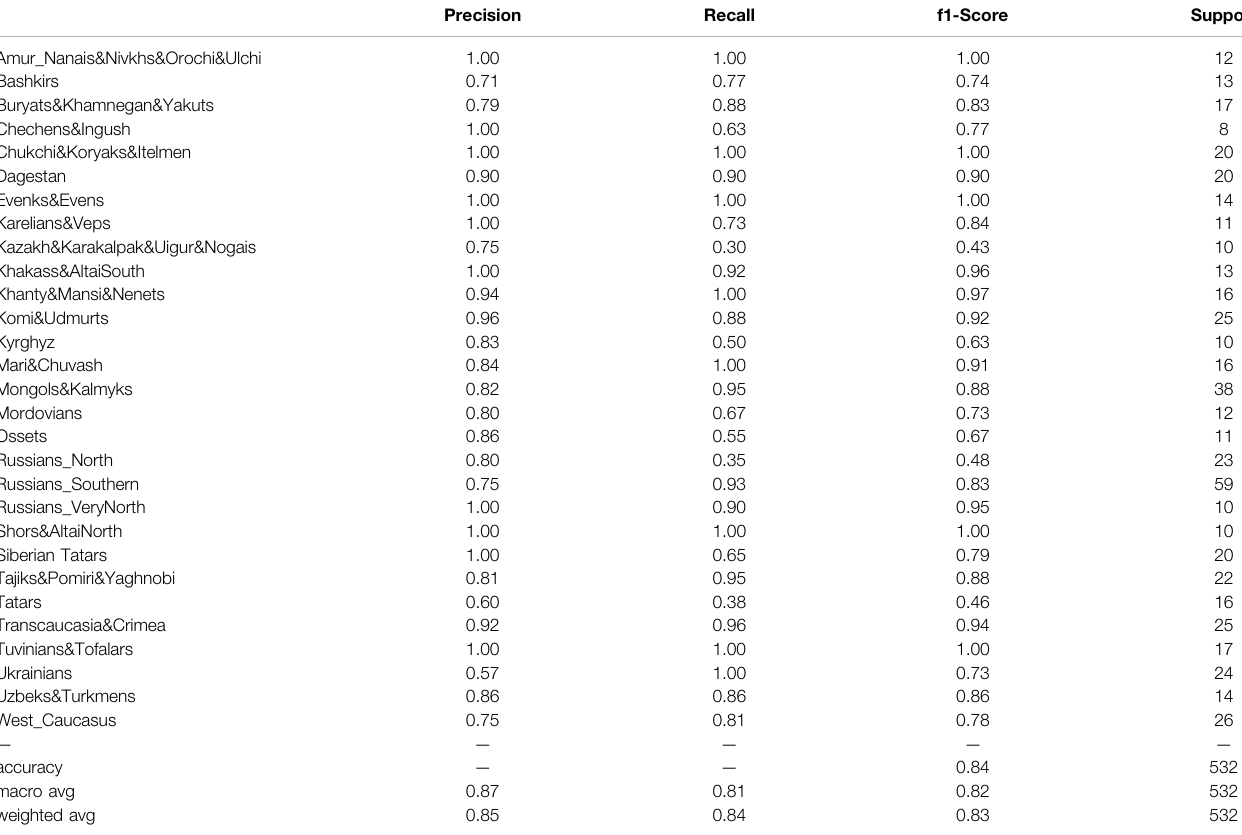
TABLE 2 | Resulting metrics of predictions for each EGG.